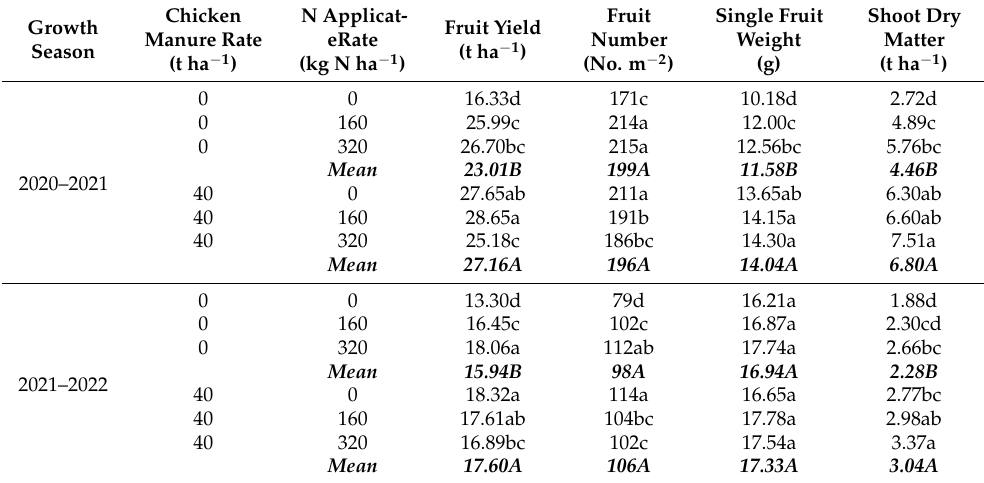
Table 1. Fruit number, single fruit weight, shoot dry matter and fruit yield of cherry tomato under the three inorganic N rates (0, 160 and 320 kg N ha − 1 ) and two different chicken manure rates (0 and 40 t ha − 1 ) during the 2020–2021 and 2021–2022 growing seasons. Growth